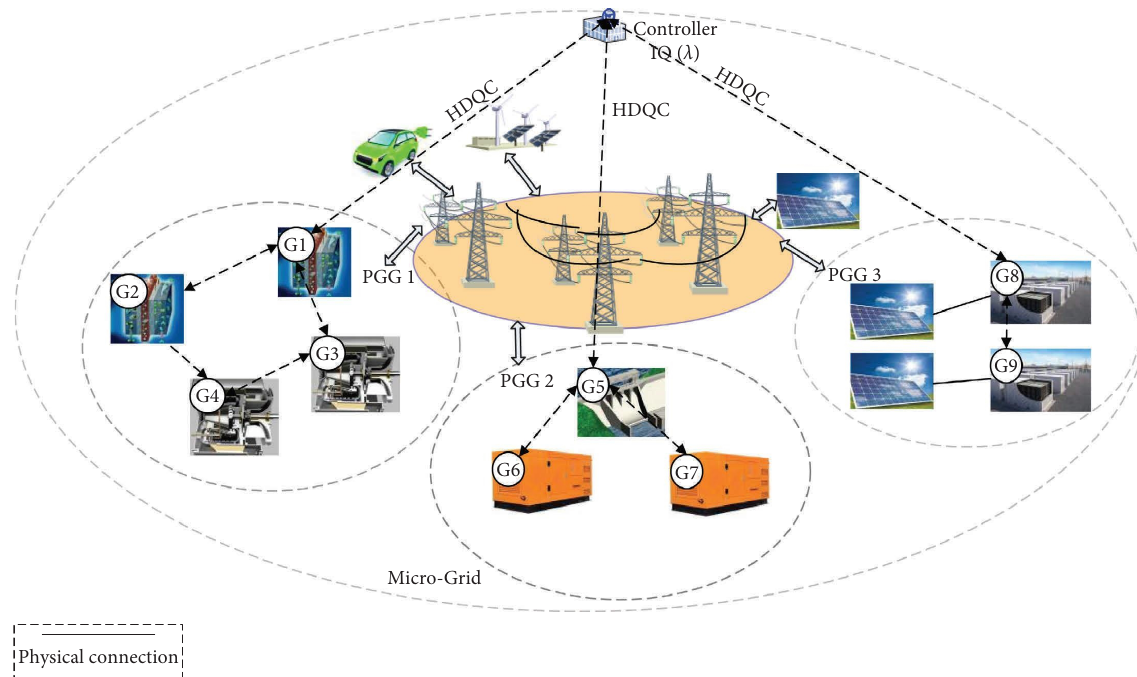
Figure 1: A microgrid control framework based on an IQ ( λ )-HDQC